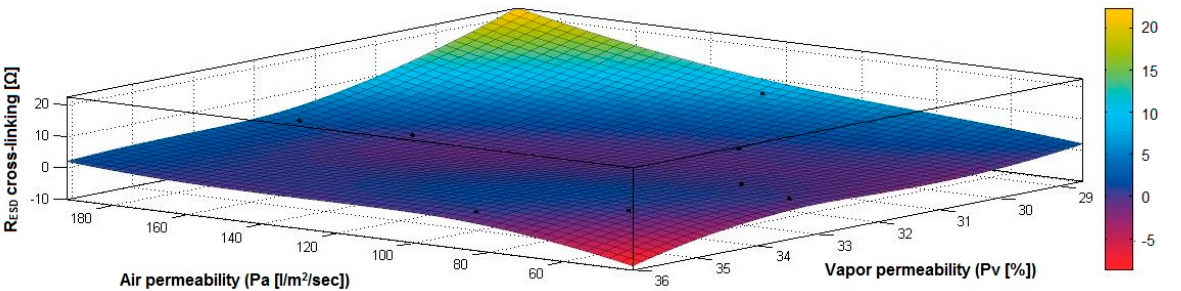
Figure 34. 3D representation R ESD after crosslinking = f(Pv, δ ) samples preliminarily treated in RF plasma O 2 using RF 2 generator and power 100 W.